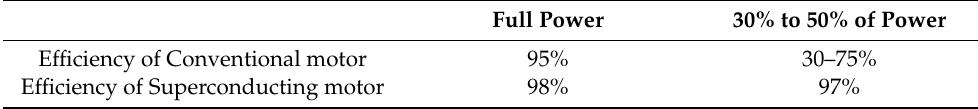
Table 2. Efficiencies of conventional and superconducting motors in different ranges of power *.